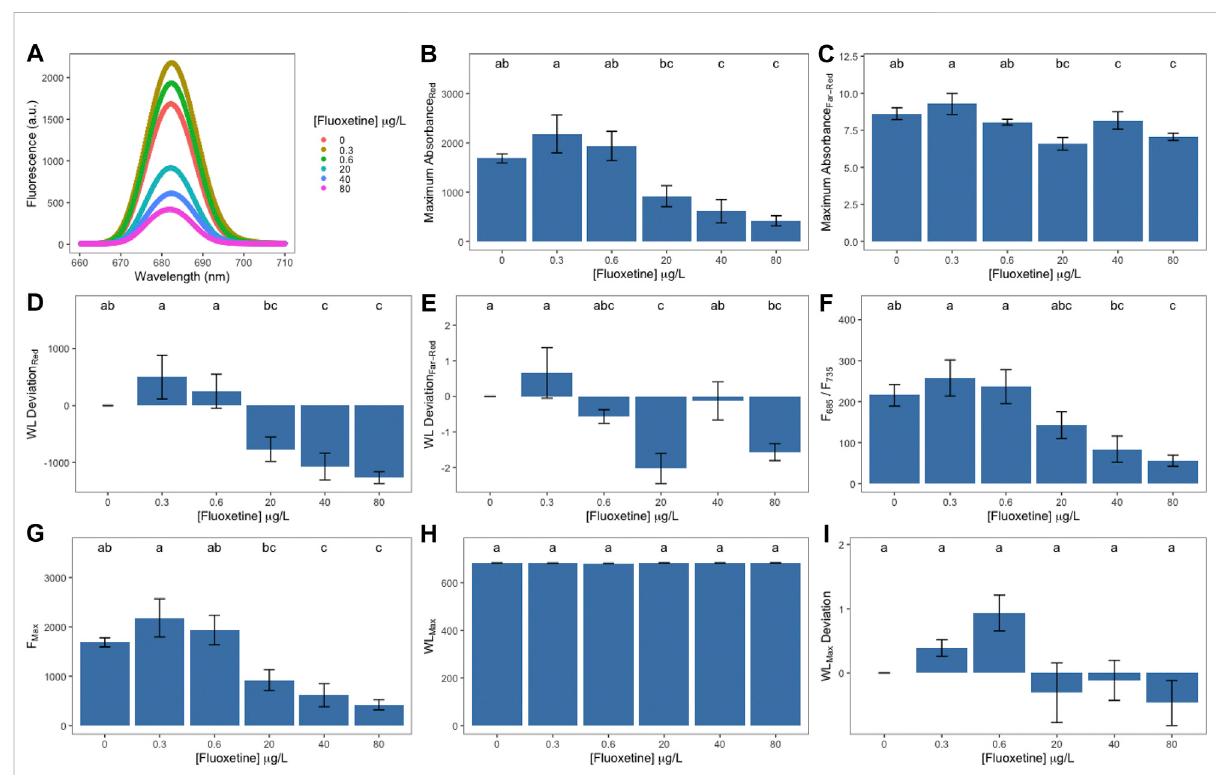
FIGURE 3 LIF-derived parameters of Ulva lactuca following a 48-h exposure to different fl uoxetine concentrations. (A) Relative fl uorescence. (B) Maximum absorbance at the red region. (C) Maximum absorbance at the far-red region. (D) Wavelength deviation at the red region. (E) Wavelength deviation at the far-red region. (F) Red/Far-red fl uorescence ratios (F685/F735). (G) Maximum fl uorescence (Fmax). (H) Maximum wavelength (WLMax). (I) Maximumwavelengthdeviation(WLMaxDeviation).Average±standarderror, N =5;differentlettersindicatesigni fi cantdifferences at p <